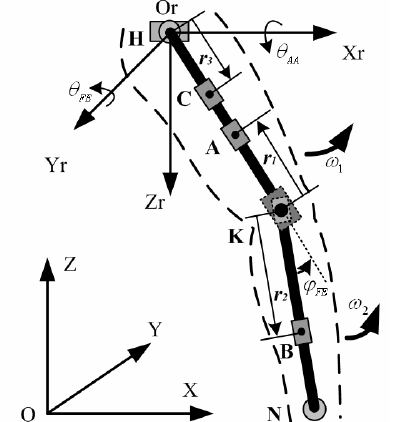
Fig.3 Lower limb model with sensors to estimate the joint rotations and positions Table 1 List of the terms used in